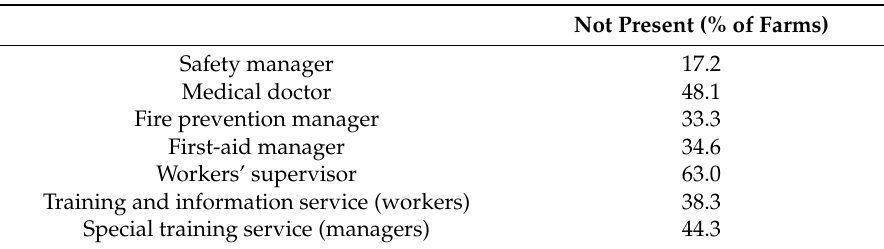
Table 3. Managers and